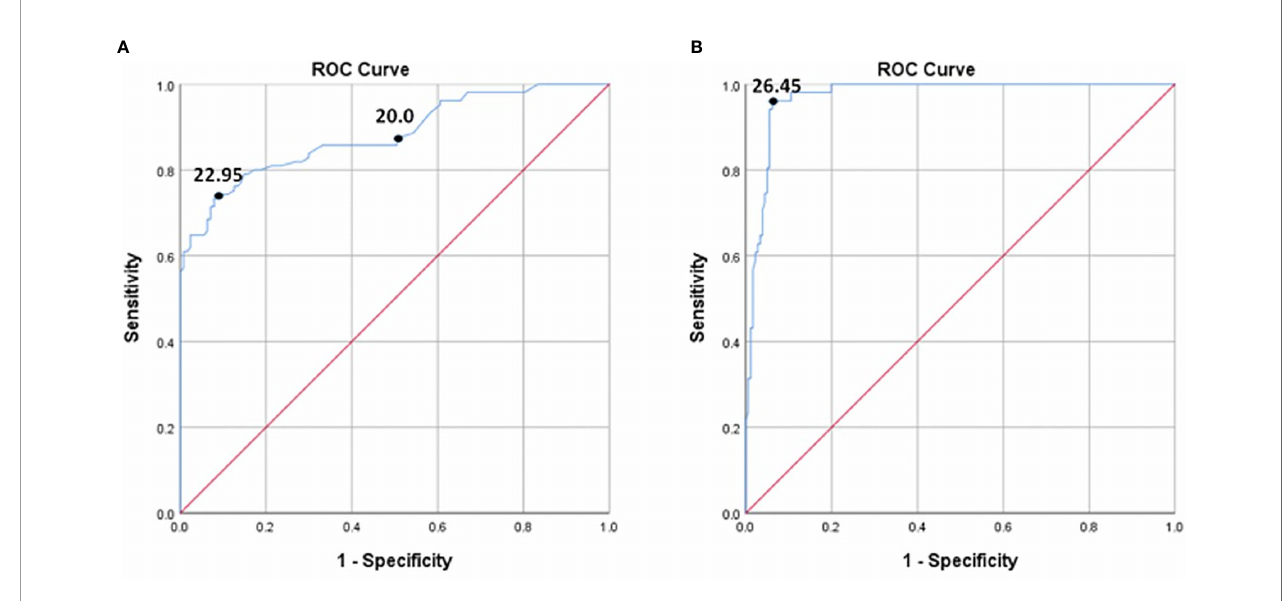
FIGURE 3 | The ROC curve for DR score to detect DR (A) and VTDR (B) .